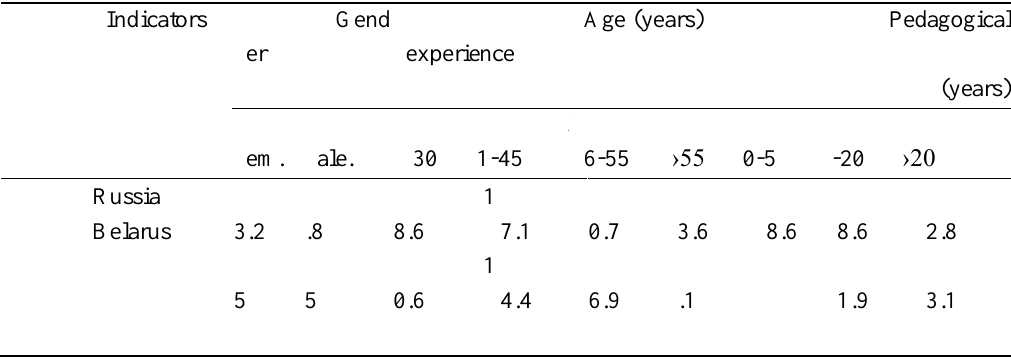
Table 1. Social-professional data of study participants (in %)